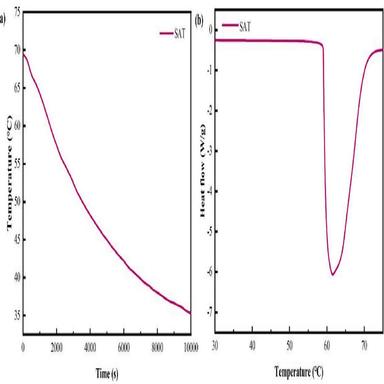
The phase change behavior of SAT. (a) step cooling curve; (b) DSC curve.